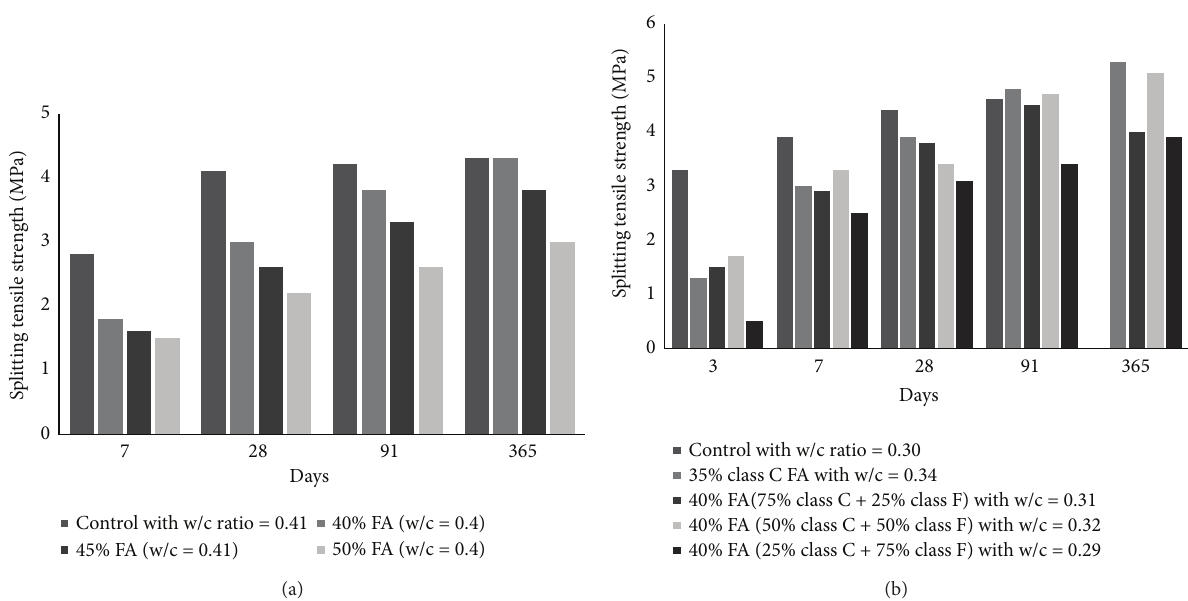
Figure 17: Effect of (a) FA type [36] (on left) and (b) cement replacement [26] (on right) on the splitting tensile strength of FA concrete.